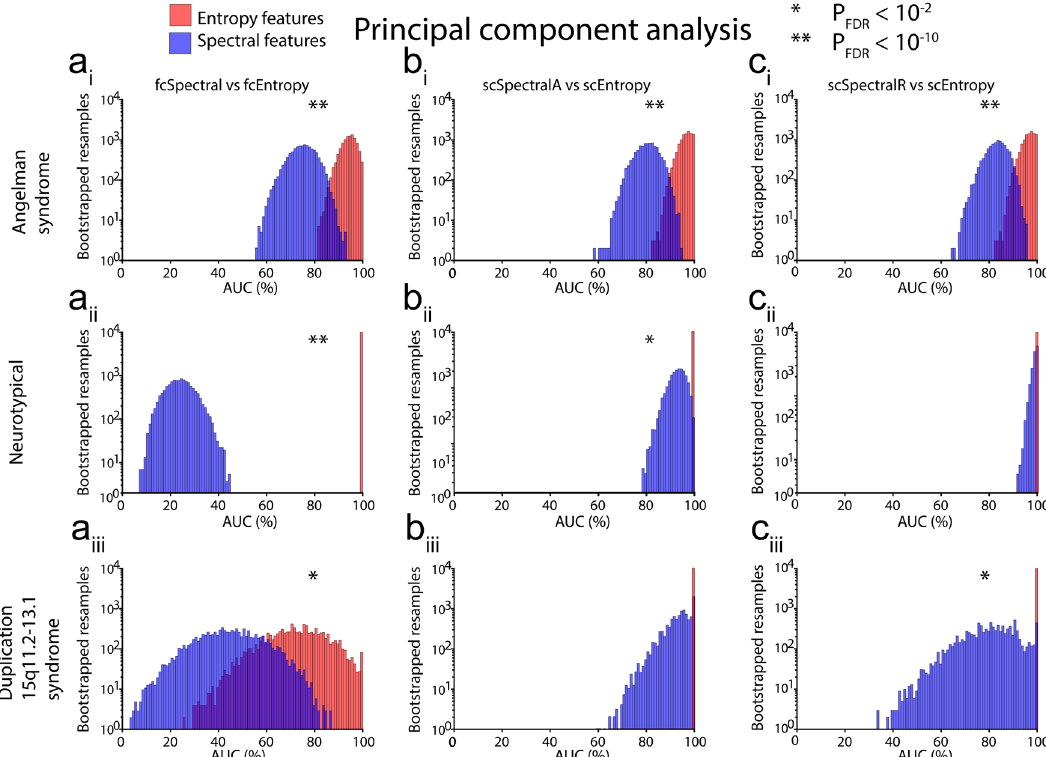
Fig. 5 Comparison of areas under the receiver operating characteristics curve (AUCs) for entropy (red) and spectral (blue) features selected using principal component analysis (PCA). We performed three basic comparisons ( a fcEntropy vs fcSpectral; b scEntropy vs scSpectralA; c scEntropy vs scSpectralR) with EEG data from three datasets [AS (top row) training data; NT (middle row) validation data; Dup15q (bottom row) validation data]. In each case, we generated 10000 bootstrapped resamples to derive AUC con fi dence intervals in Supplementary Table 3. Note that the number of resamples on the vertical axis of each histogram is log-scaled due to the very large range of resamples across histogram bins. Also note that classi fi er performance was saturated using entropy features for all comparisons using NT data and two comparisons using Dup15q data, i.e., all bootstrapped resamples yielded 100% AUC for entropy features in these instances. Seven out of the nine comparisons above yield signi fi cantly larger AUCs for entropy features, as indicated by asterisks. Source data are presented in Supplementary Data